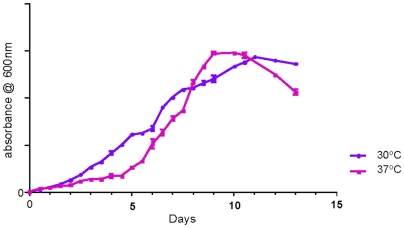
Growth rate analysis of MIP:
MIP was cultured in MB7H9-ADC medium at 30°C and 37°C. The A600nm of liquid culture of MIP was plotted against time to analyze the pattern of MIP growth. Growth was monitored by measuring the change in the value of A600nm over time. Each experiment was performed with replicates and error bars for each time point are shown. A typical growth curve with three distinct phases was generated with culture becoming saturated in 8 to 10 days.